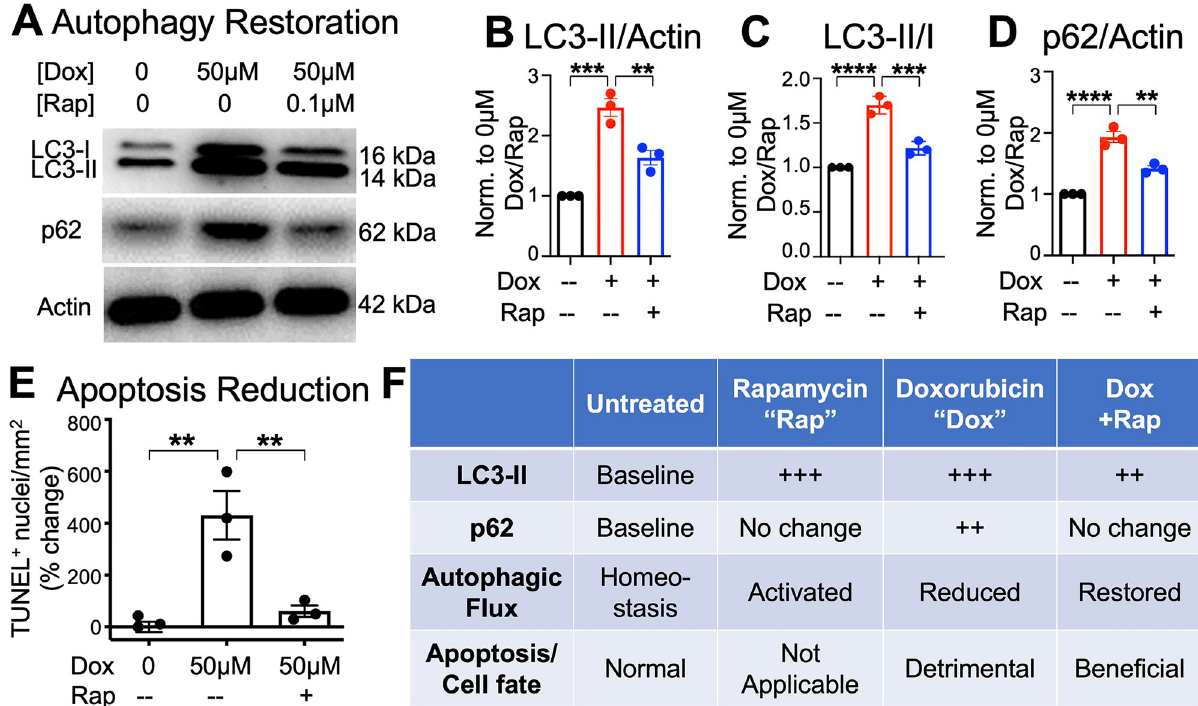
Fig 4. Autophagy induction by rapamycin significantly attenuated cardiomyocyte apoptotic cell death. Cardiac slices were exposed to 50 μ M doxorubicin with or without rapamycin (Rap) co-treatment. A-D. Representative immunoblots and quantification of LC3-II and p62. E. Expression increases of LC3-II and p62 with doxorubicin were mitigated with rapamycin co-treatment for 24 hours, leading to cardiomyocyte apoptosis reduction. N = 3. F. The effects of doxorubicin, rapamycin, and chloroquine treatment on LC3-II and p62 expression, and the overall effect on autophagic flux and apoptotic cell death are summarized. �� p < 0.01, ��� p < 0.001, ���� p < 0.0001, ANOVA with Tukey post-test.